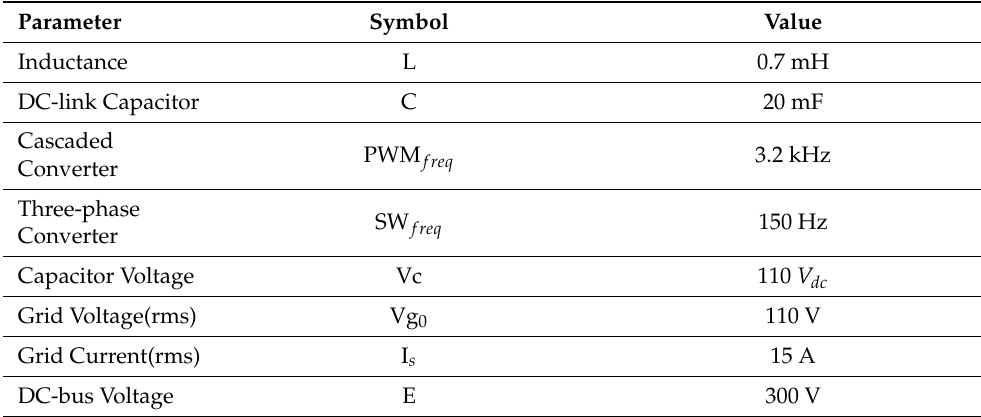
Table 4. Proposed system’s parameters.